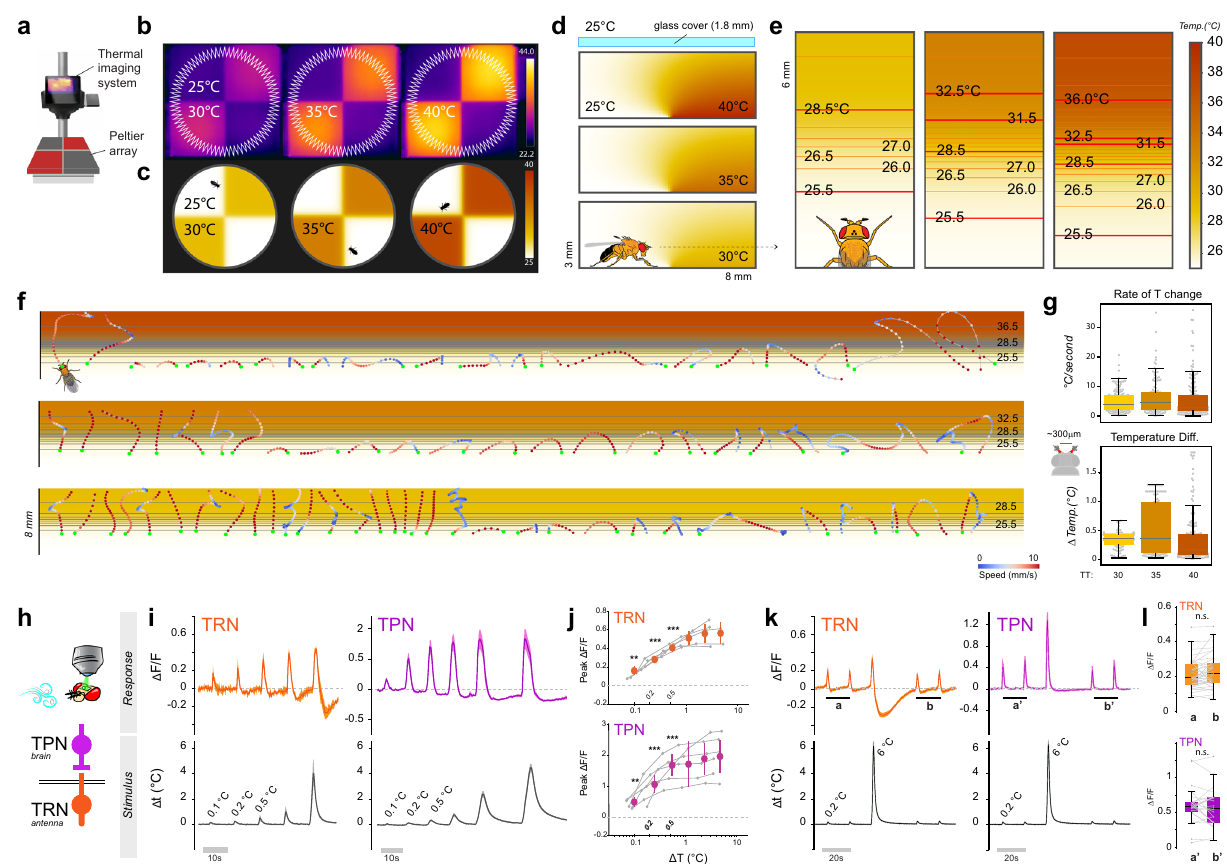
Fig. 3 A three-dimensional simulation of the thermal environment reveals small temperature differences are salient stimuli. a Schematic representation of the thermal imaging system. b Thermal images of the arena in the three experimental conditions, and ( c ), at the same scale, thermal conditions predicted by the simulation (see scale bars for temperature). d Side view of a 3 x 8mm section of the experimental chamber, centered on the interface between fl oor tiles set at 25°/30°, 25°/35°, and 25°/40 °C, respectively, and showing the predicted thermal conditions (note that the glass cover on top is not to scale). e Top view of the simulated thermal gradients the fl y encounters at the cool/hot boundary, produced by slicing the 3D model at the height of the antennae (~700 μ m; note that the 3 panels are not aligned; scalebar: temperature in °C). f Representative fl y trajectories overlaid atop the gradients in ( e ). Tracks are color-coded by translational speed (see scalebar). Each dot represents the position of the fl y head (acquired at 30 Hz). A green dot indicates the fl y head position upon entry in the boundary region. g Maximum rate of temperature change (top) and maximum inter-antennal temperature difference (bottom) experienced by fl ies traversing the border in the three experimental conditions. h Schematic representation of the 2-photon calcium imaging setup and of the cell types targeted for recording (temperature receptor neurons, TRN and second-order projection neurons, TPN). i Average stimuli (bottom) and response traces (top) recorded from TRN axon terminals (orange trace, left) and TPN (purple trace, right) each separately targeted by transgenic expression of G-CaMP7f (traces represent average ±STD of N TRN = 5 from 5 fl ies, N TPN = 6 from 6 fl ies). j Orange and purple dots, peak fl uorescence averages from data in ( i ), ± STD (bin width starting at 0.1 °C and doubling in size for each consecutive bin; asterisk = signi fi cantly different from zero, one sample t test, P < 0.05; t test TRN: P 0.1 = 3.5e − 3, P 0.2 = 1.5e − 6, P 0.5 = 4.1e − 4; TPN: P 0.1 = 2.1e − 3, P 0.2 = 1.5e − 4, P 0.5 = 9.0e − 5). k , l Exposure to a larger heat stimulus does not lead to sensitization to smaller stimuli. k Average stimuli (bottom) and responses (top) ± STD. l Average peak signal recorded before ( a , a ′ ) and after ( b , b ′ ) a 6 °C stimulus are not different (n.s. not signi fi cant; paired t tests; ( k ) and ( l ) are from N TRN = 18, N = 12 from 7 and 6 animals, respectively; note that the twin peaks in ( a , a ′ , b , and b ′ ) are considered independently in ( l TPN